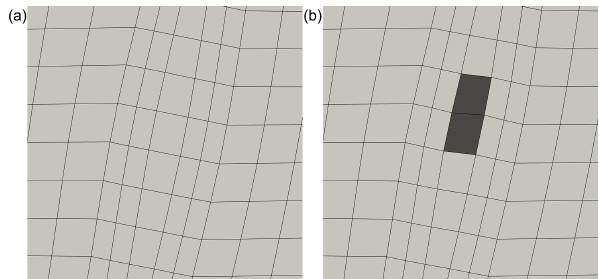
Figure 6. State of deformation around the point of injection, defor- mations exaggerated by a factor of 1000. (a) shows the grid with only elastic deformations, (b) displays a distortion in the failed ele-